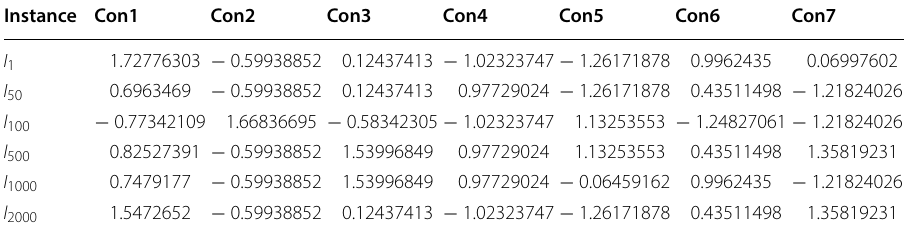
Table 1 Context normalization utilizing the dataset of user U1 Instance Con1